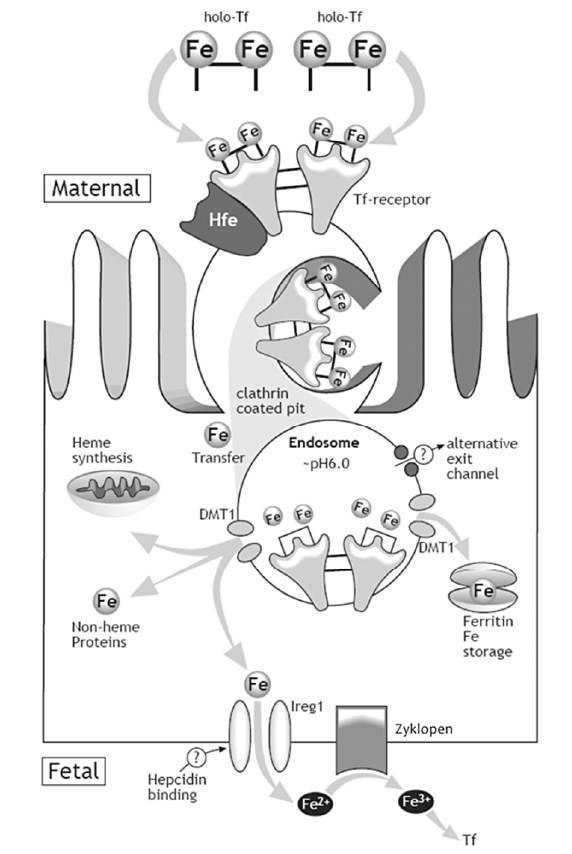
Figure 2. Mechanism of iron transfer across the placenta. The syncytiotrophoblast takes up iron-transferrin from maternal circulation via the transferrin receptors (TfR) cycle. After the holo-Tf/TfR complex is endocytosed, and iron is released from the complex in the acidifed endosome, iron is transported into the cytosol likely by the divalent metal transporter-1 (DMT-1). Iron is exported from the basolateral side of the synctiotrophoblast into fetal circulation by ferroportin (Ireg1). A ferroxidase (possibly zyklopen) oxidizes iron so it can be loaded onto fetal transferrin [28]. (with permission to publish photo from Nutrition